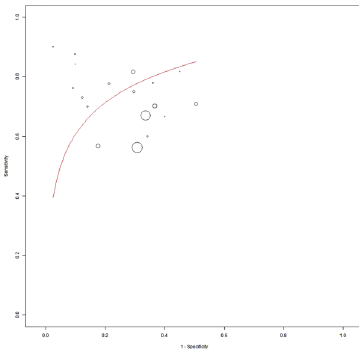
Figure 4: ROC diagram of AFU.